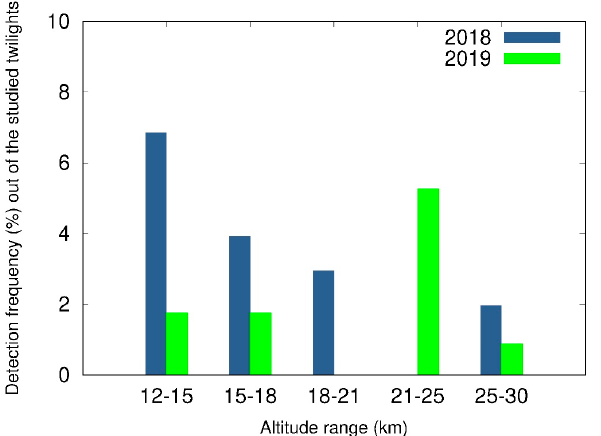
Figure 9. Occurrence frequency (out of the studied twilights) of derived altitudes in % (2018 in blue, 2019 in green) out of the number of studied twilights.